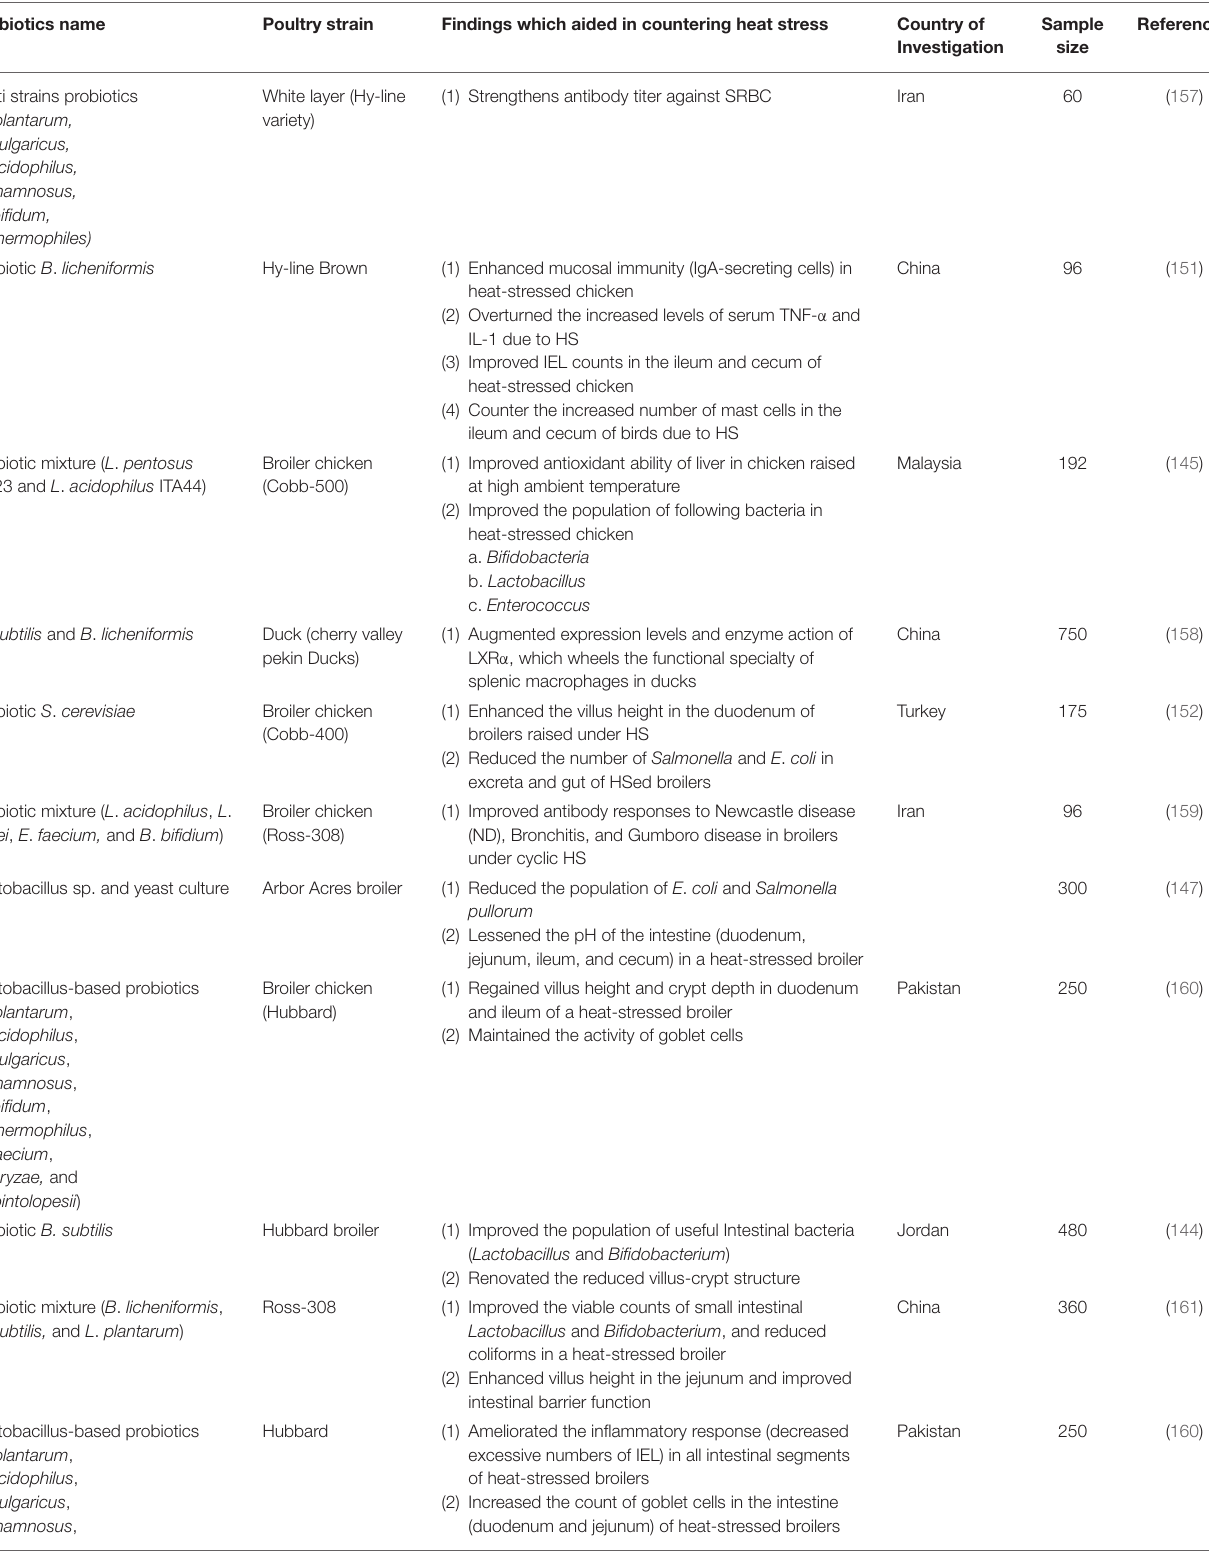
TABLE 1 | Role of different probiotics to counter the damaging impact of heat stress in